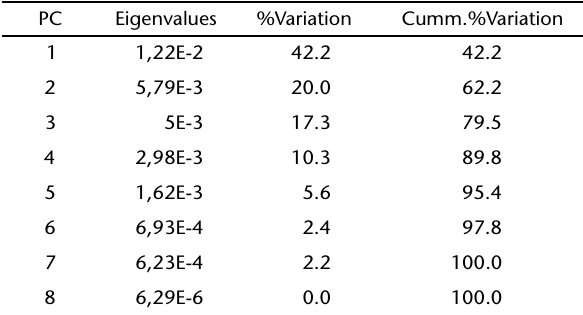
Table III. Results of the PCA, including eigenvalues and percentages of variability explained for PC’s of populations of Mesocyclops thermocyclopoides